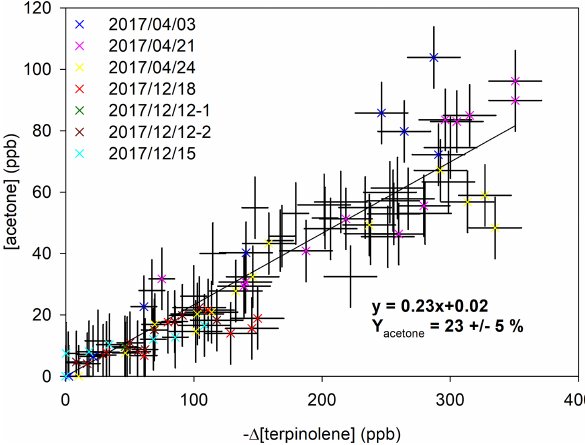
Figure 7. Acetone production vs. loss of